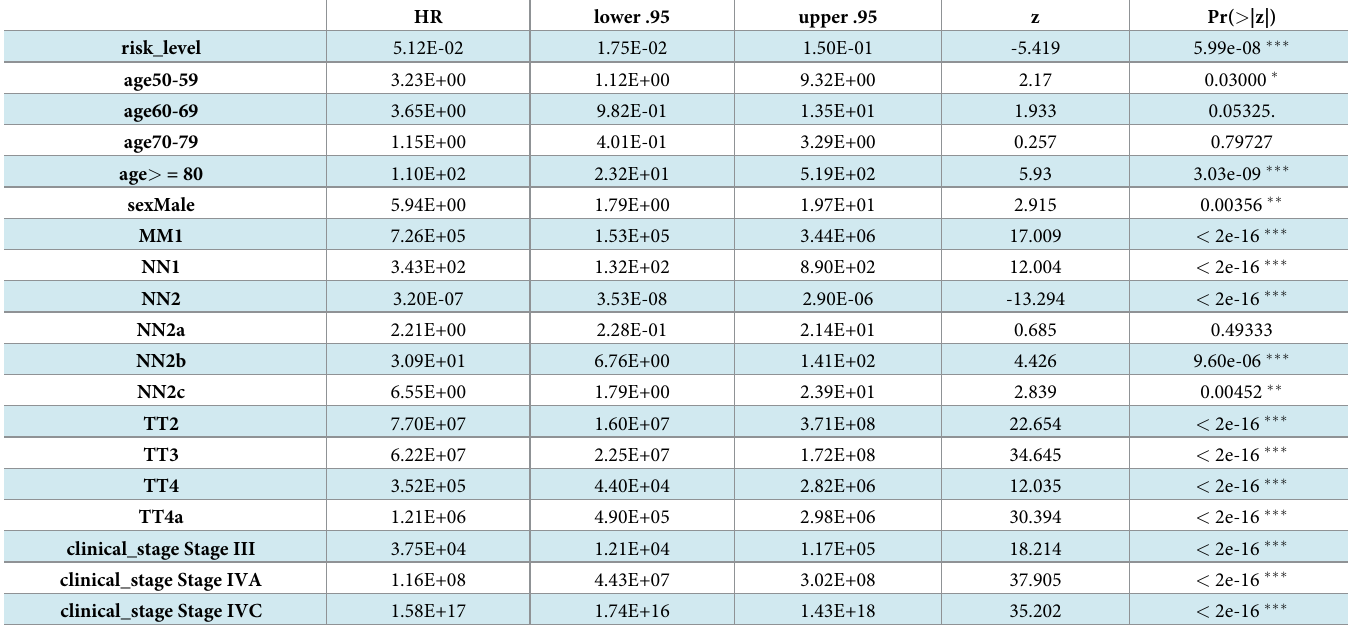
Table 3. The multivariate analysis of both clinical factors and 3 mRNA signatures. HR lower .95 upper